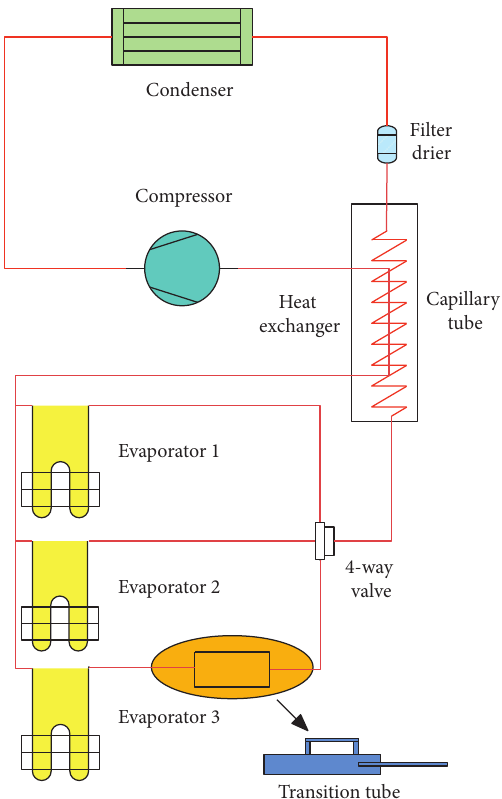
Figure 5: Refrigeration system with a transition pipe.